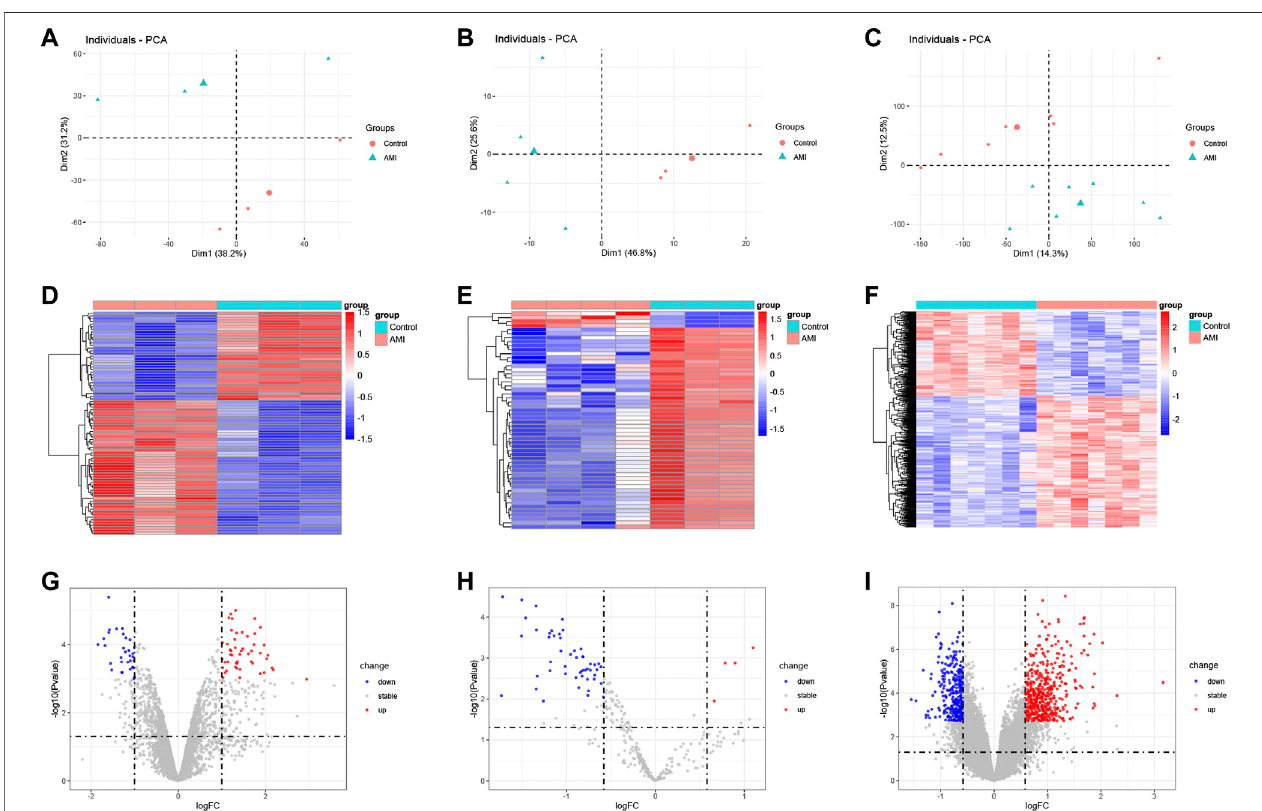
FIGURE1| HeatmapandvolcanoplotoftheDEcircRNAs,DEmiRNAs,andDEmRNAsbetweenAMIandthenormalcontrols. (A) theprincipalcomponentanalysis ofGSE160717. (B) theprincipalcomponent analysisofGSE24548. (C) theprincipalcomponent analysisofGSE60993. (D) heatmapofDEcircRNAs from GSE160717.